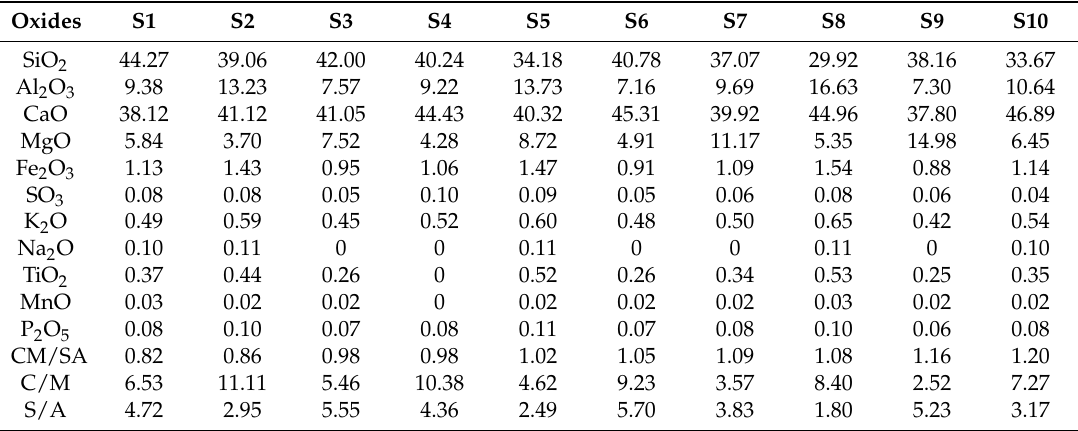
Table 5. Chemical compositions of air quenched slags determined by XRF